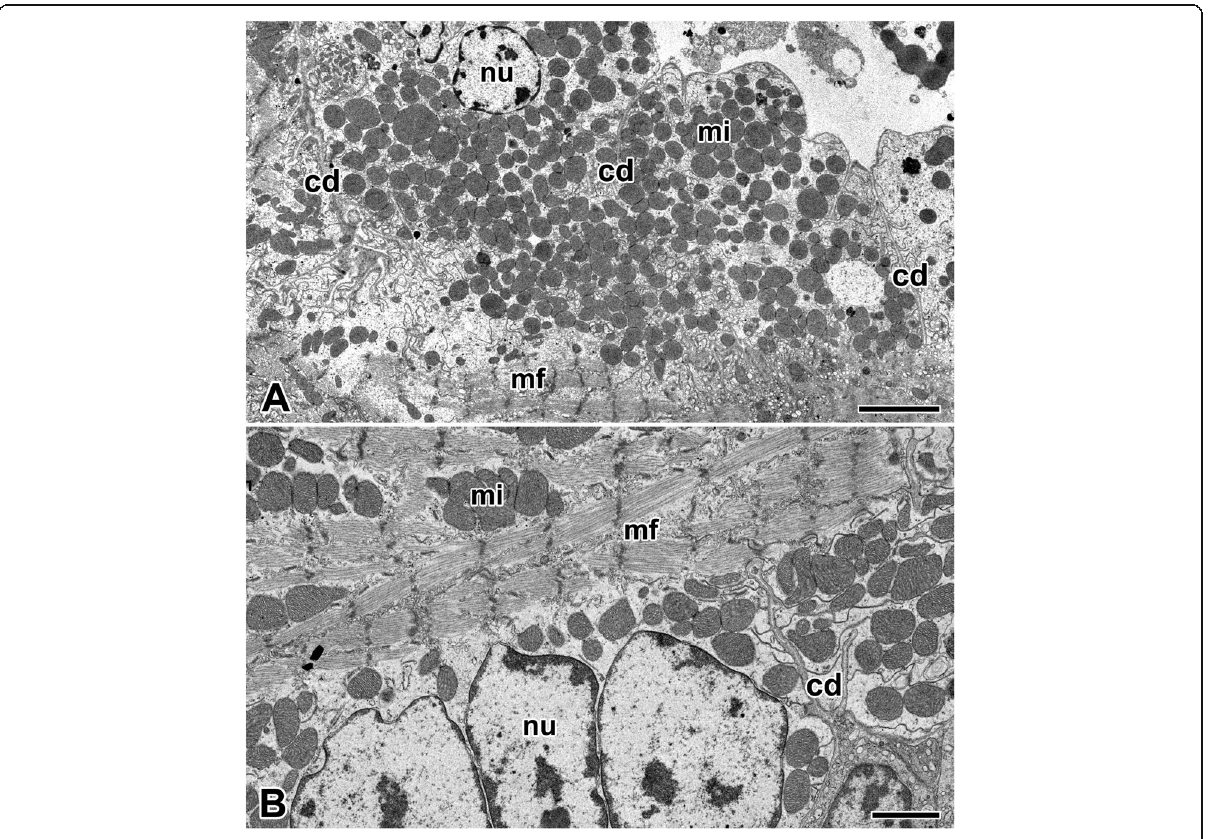
Fig. 1 Electron micrographs of the cardiac muscle cells in the orb-web spider, N. clavata . a : Cardiac muscle cells contain densely packed mitochondria (mi) and myofibrils (mf) within the cytoplasm. Adjacent cells are tightly connected by intercalated disc (cd). b : Cardiac muscle cells show myofibril striations with distinct sarcomeres defined by Z-lines. Multinucleate cardiac muscle cell that has more than one nucleus (nu) per cell is seen. 5 μ m ( a ), and 2 μ m ( b